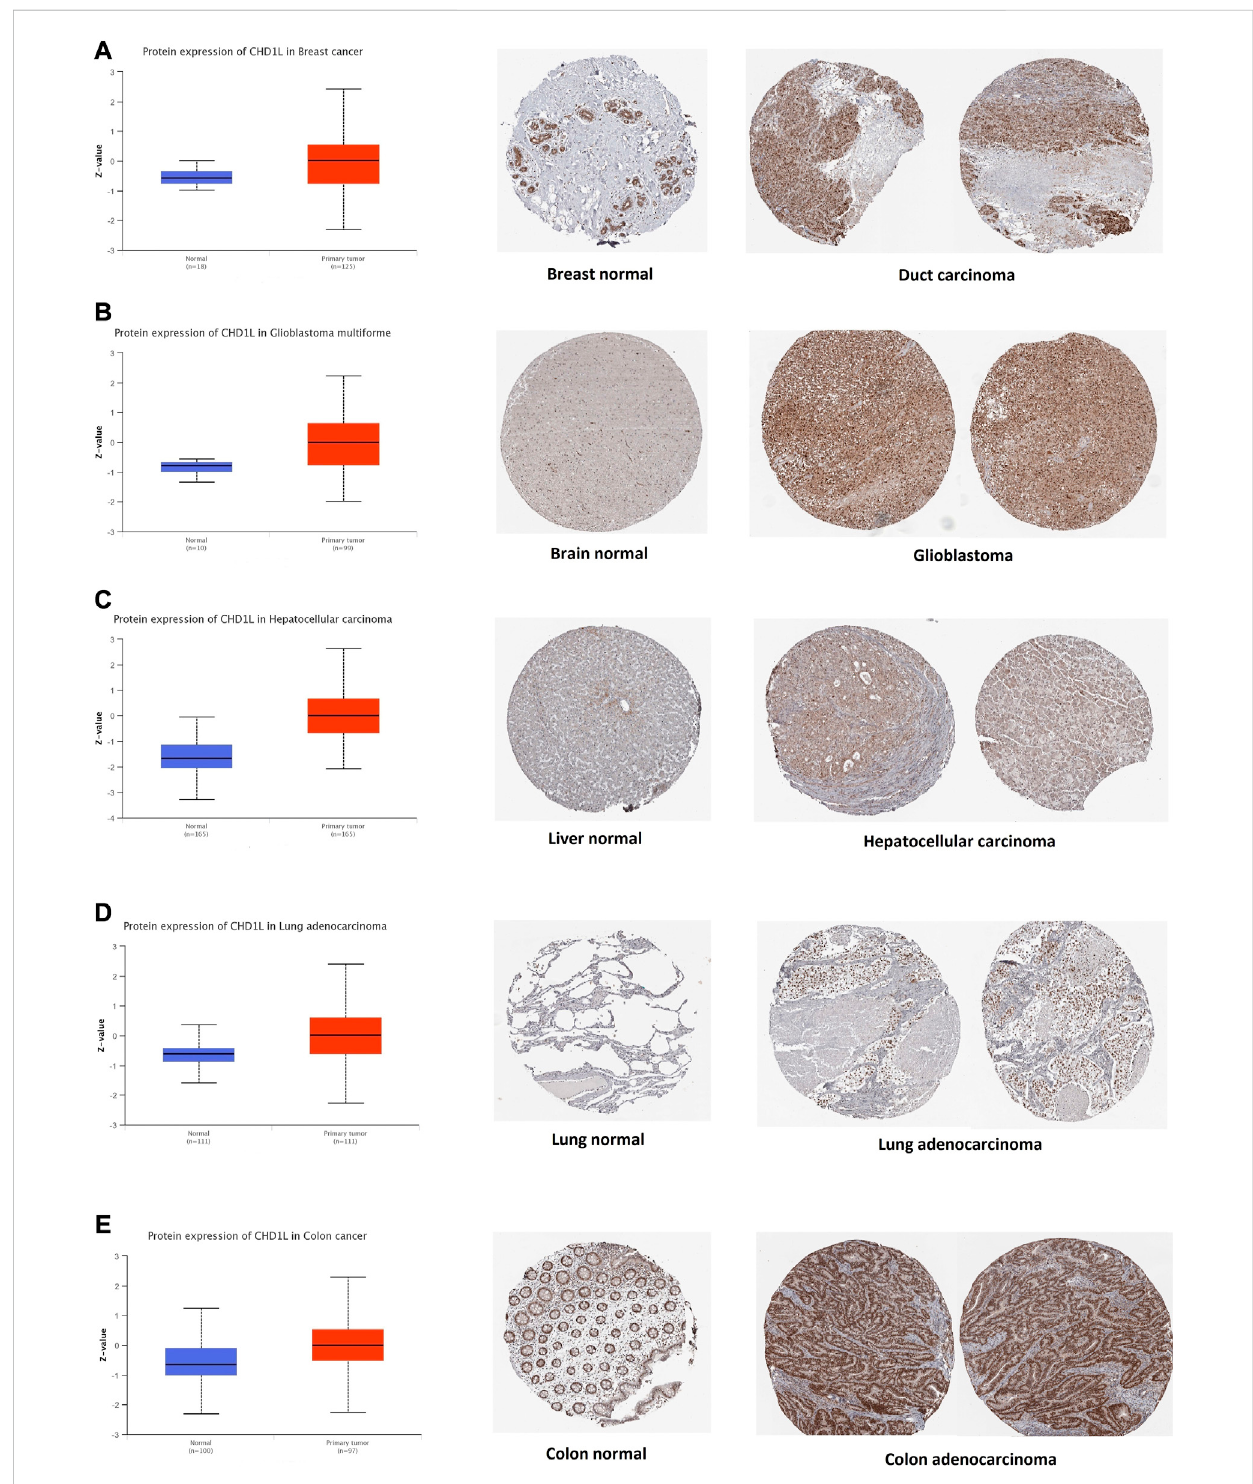
FIGURE 2 Tumorsexperiencedastatisticallysigni fi canthigherCHD1Lproteinexpressioninthetumorsampleversusnormalone(leftside)andIHCstainingfor normal tissue (middle) and cancerous one (left) demonstrated the same results. (A) Breast. (B) Brain. (C) Liver. (D) Lung. (E)